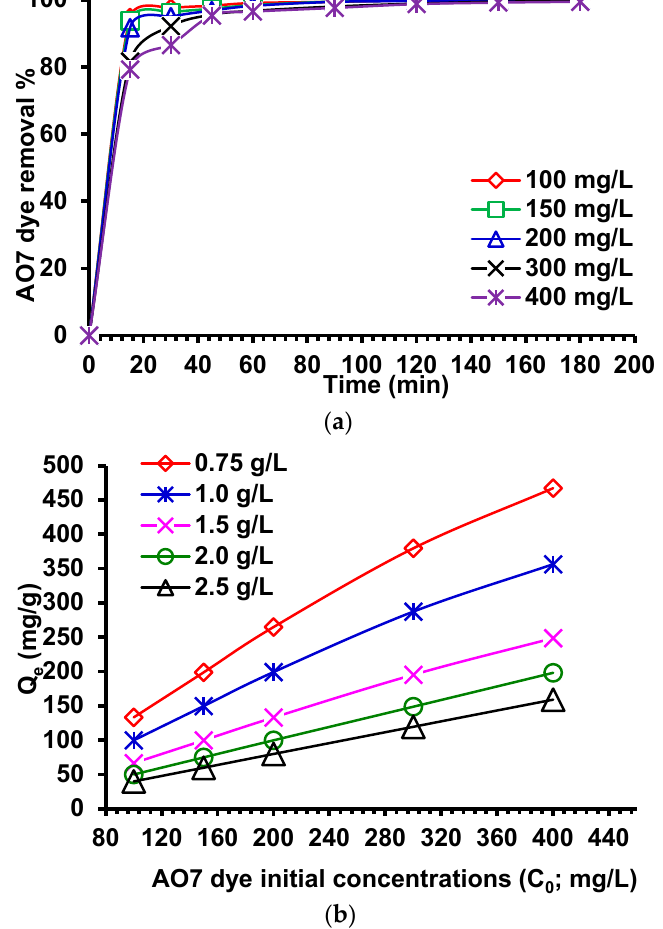
Figure 9. ( a ) Relation between removal % and contact time (min) of AO7 dye using different initial concentrations on 2.5 g/L of pea pods AC/ZnCl 2 at 25 ± 2 °C; ( b ) relation between Q e (mg/g) and different initial concentrations (100–400 mg/L) of AO7 dye using different AC/ZnCl 2 (0.75–2.5 g/L) at 25 ± 2 °C.